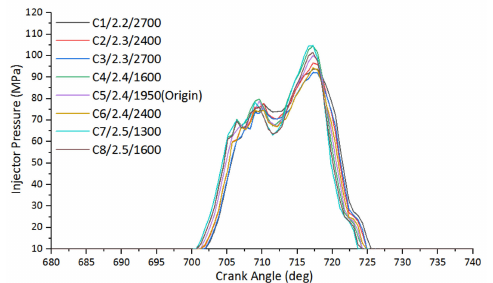
Figure 32. Volume optimization plan for injector pressure.